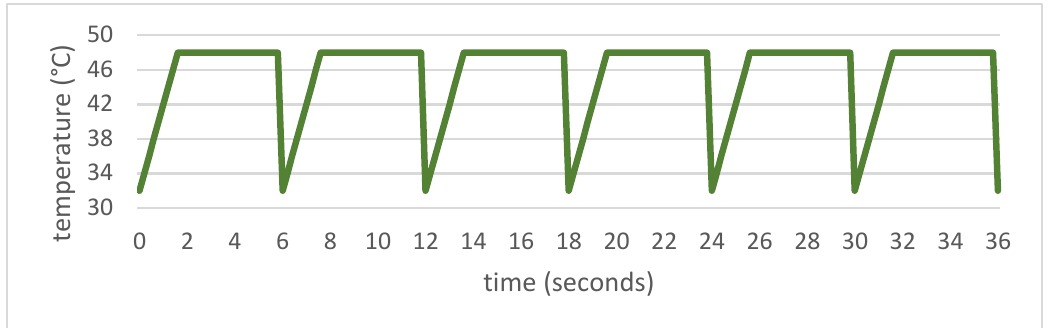
Figure 2. Time course of the thermode temperature in the “repetitive phasic heat application” pain paradigm. This block of six heatings was followed by a 30 s break. The whole procedure was repeated 10 times.